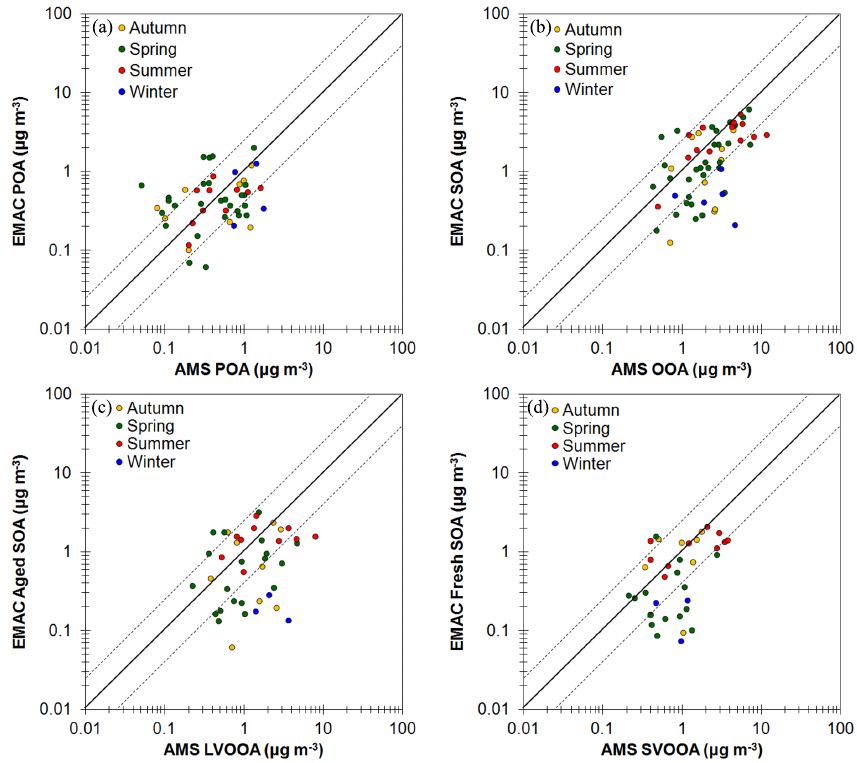
Figure 13. Scatter plots comparing model results to AMS for (a) POA, (b) OOA, (c) LV-OOA, and (d) SV-OOA concentrations (in µgm − 3 ) in the Northern Hemisphere during 2001–2010. Each point represents the data set average value and is colored based on the season of the field campaign. Also shown are the 1:1, 2:1, and 1:2